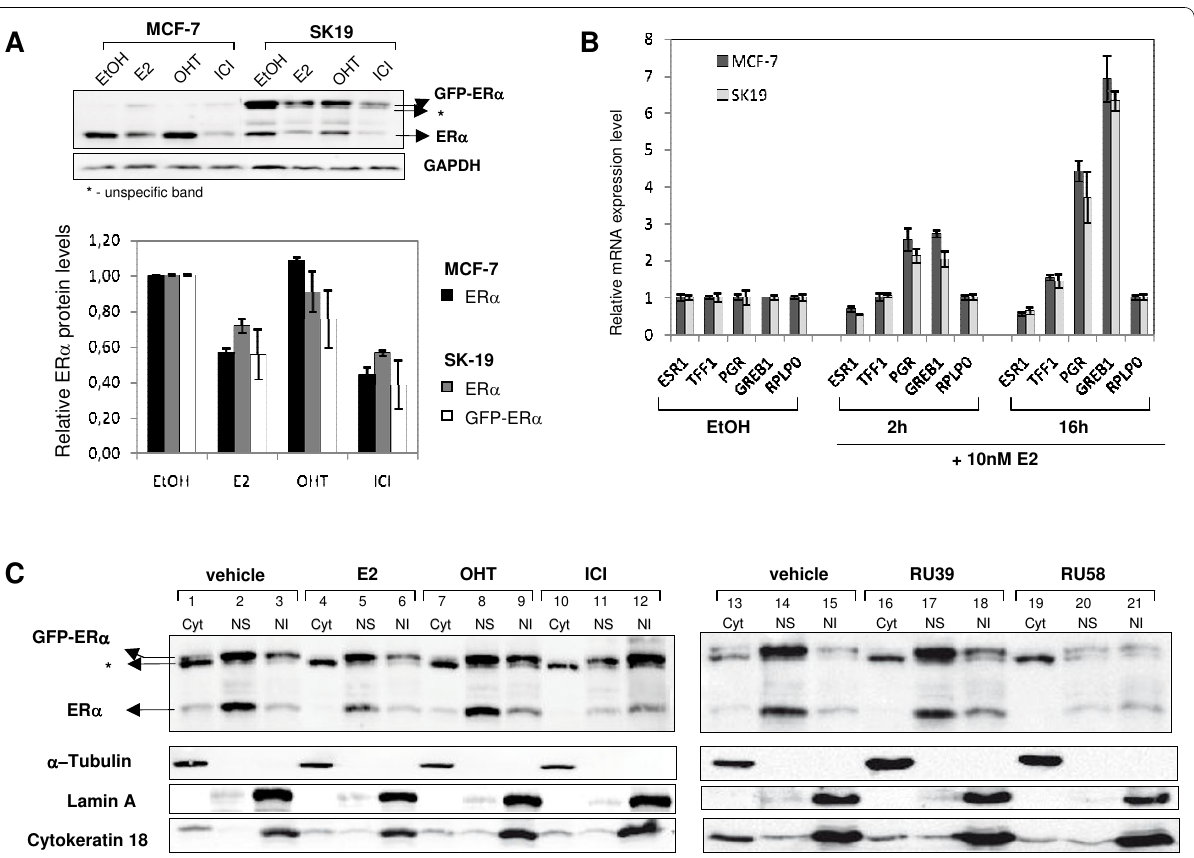
Figure 2 Nuclear accumulation and degradation of the estrogen receptor alpha in MCF7 and SK19 cells . A) Protein levels of endogenous ER a and GFP-ER a in MCF-7 and SK19 cells in response to E2 and to anti-estrogens. The SK19 cell line was generated from MCF-7 cells by